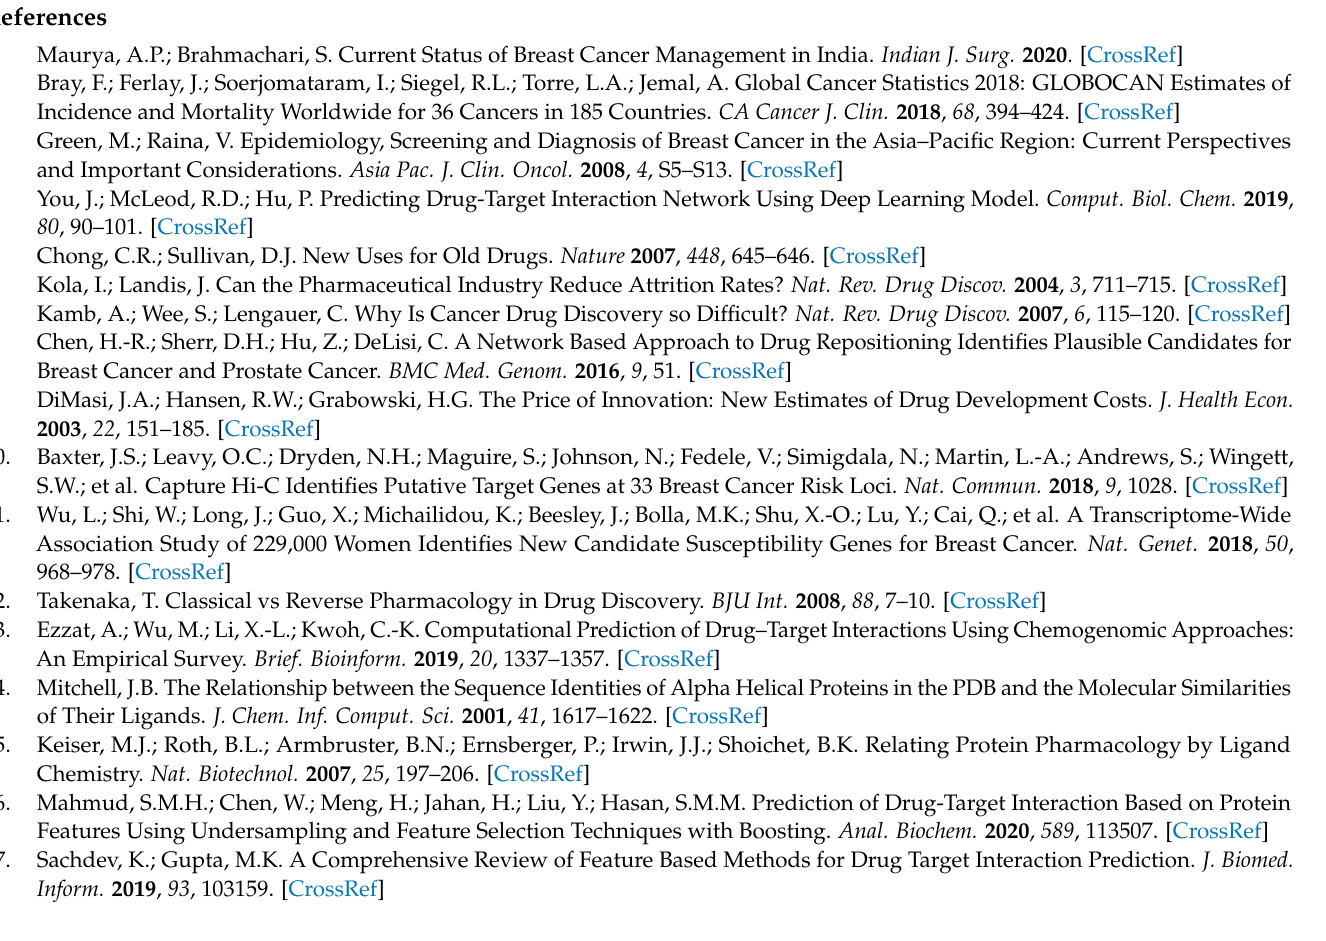
contains EGF. Table S1: Targets for drug repurposing of breast cancer, Table S2: Prediction result of selecting different λ on four datasets, Table S3: Prediction result of selecting different s on four datasets, Table S4: Prediction results on four datasets before and after Lasso for dimensionality re- duction, Table S5: Prediction results on four datasets before and after SMOTE optimization, Table S6: Prediction results on four datasets of seven classifiers, Table S7: Drug-target interaction pairs with a probability score no less than